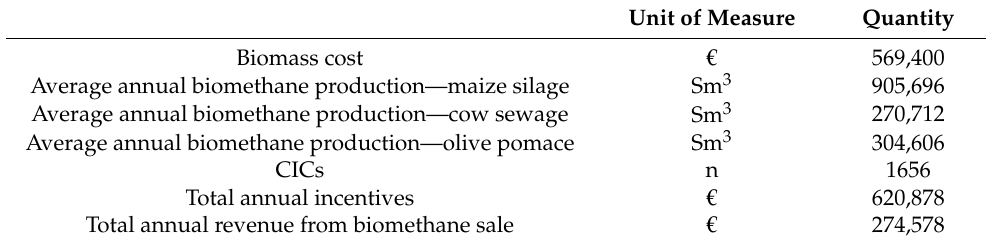
Table 3. Results of Example 2.